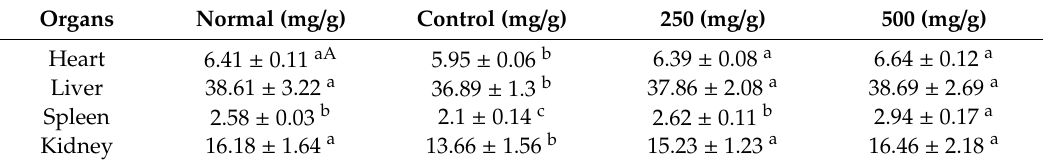
Table 2. E ff ects of Apocynum venetum tea extract (AVTE) on organ coe ffi cient in aging mice induced by d